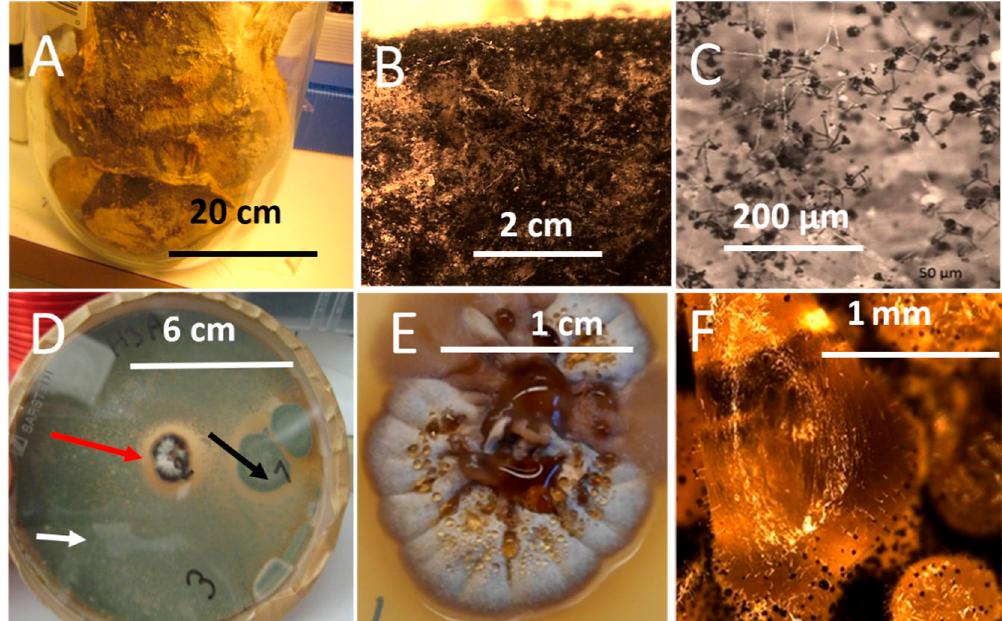
Figure 7. Stachybotrys sp. biomass on water-damaged paperboard (upper row) and on malt extract agar (lower row). The paper board was stored for <20 years in a sealed glass jar ( A ). Stereomicrographs of the paperboard showed black microbial growth ( B ) and conidiophores characteristic for Stachybotrys ( C ), with no exudates or vesicles visible. Panel ( D ) shows a malt extract plate inoculated with biomass scrapings from the paper board. After 3 week the plate was covered by green Penicillium -like growth (white and black arrows), and a black antagonistic Stachybotrys -like colony (red arrow) appeared. Panels ( E ) and ( F ) show stereomicrographs of the Stachybotrys -like colony, pure cultured, named HJ5 and pictured after 1 and 3 weeks of incubation, respectively. Panel ( F ) shows large liquid-containing film-surrounded droplets covered by black conidiophores.